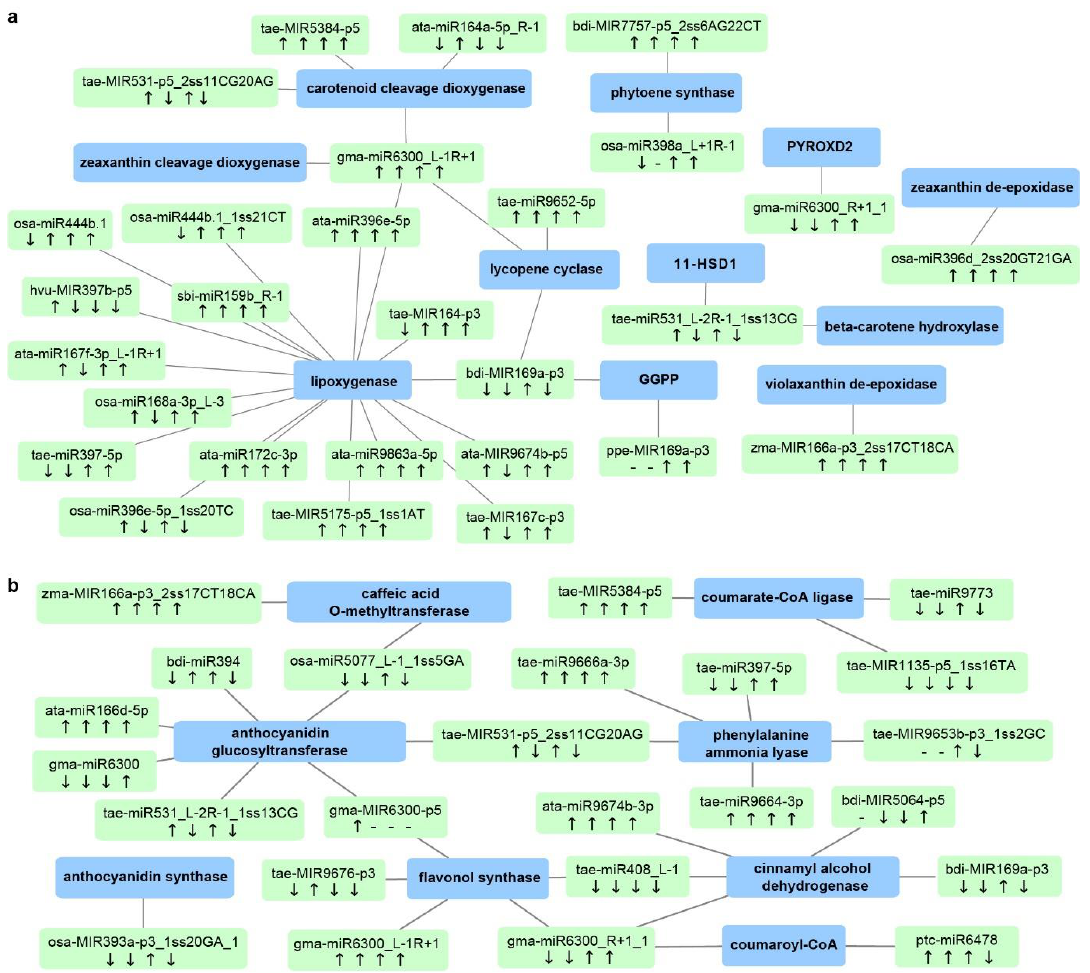
Figure 8. Durum miRNA–mRNA modules involved in ( a ) carotenoid biosynthesis and ( b ) the phenylpropanoid pathway. Green boxes represent miRNAs, while blue boxes represent target genes. “ ↓ ” indicates that miRNA expression was lower in the stress-tolerant genotype DBA Aurora when compared with L6; “ ↑ ” indicates that miRNA expression was higher in the stress-tolerant genotype DBA Aurora when compared with L6. The four arrows represent the miRNA / gene expression pattern under control, water deficit stress, heat stress, and water deficit plus heat stress. “-” indicates that the gene expression pattern was not available due to no expression. For genotypic di ff erences in target gene expression pattern under the four treatment conditions, see Table S13. Abbreviations: 11-HSD1 (11-hydroxysteroid dehydrogenase type 1); GGPP (geranylgeranyl diphosphate reductase); PYROXD2 (pyridine nucleotide-disulfide oxidoreductase domain-containing protein 2). For genotypic di ff erences in miRNA and target gene expression patterns under four treatment conditions, also see Table